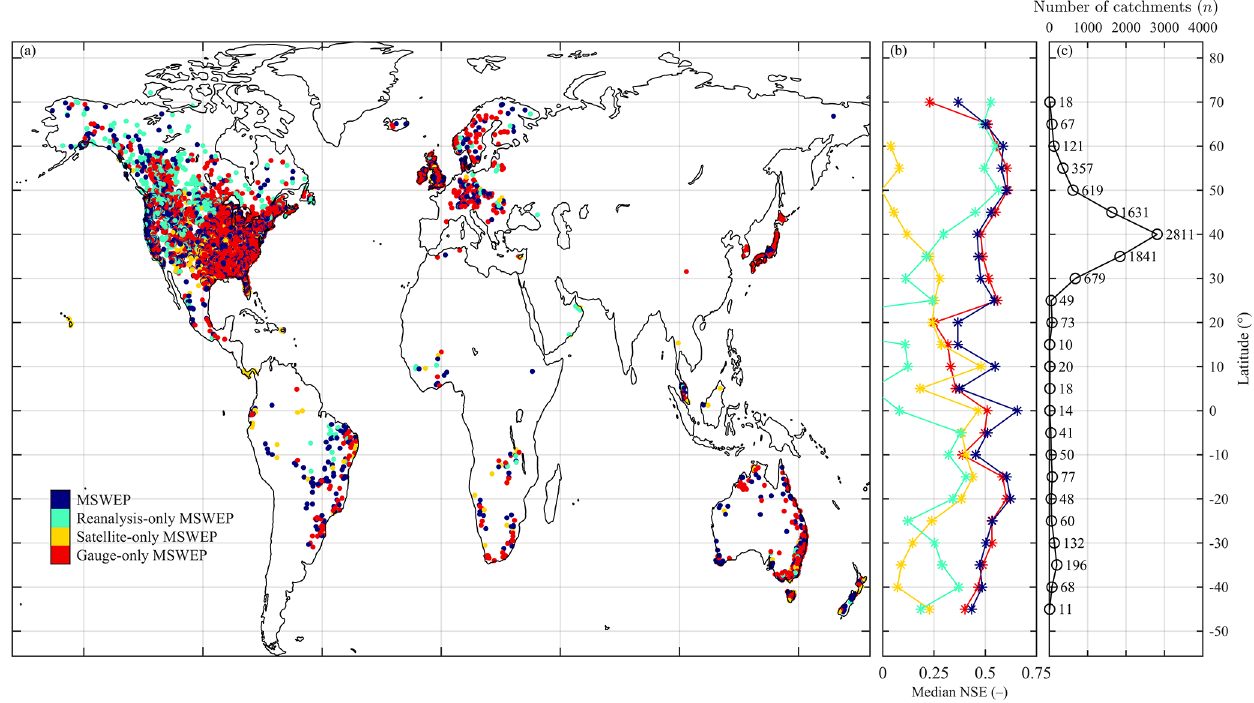
Figure 8. The P dataset with the best daily NSE score obtained after calibration of HBV is shown in (a) . Also shown are (b) median NSE scores for 5 ◦ latitude bands and (c) the number of catchments ( n ) for each 5 ◦ latitude band. Each data point in (a) represents a catchment centroid ( N = 9011). The NSE scores have been computed between simulated and observed Q time series.